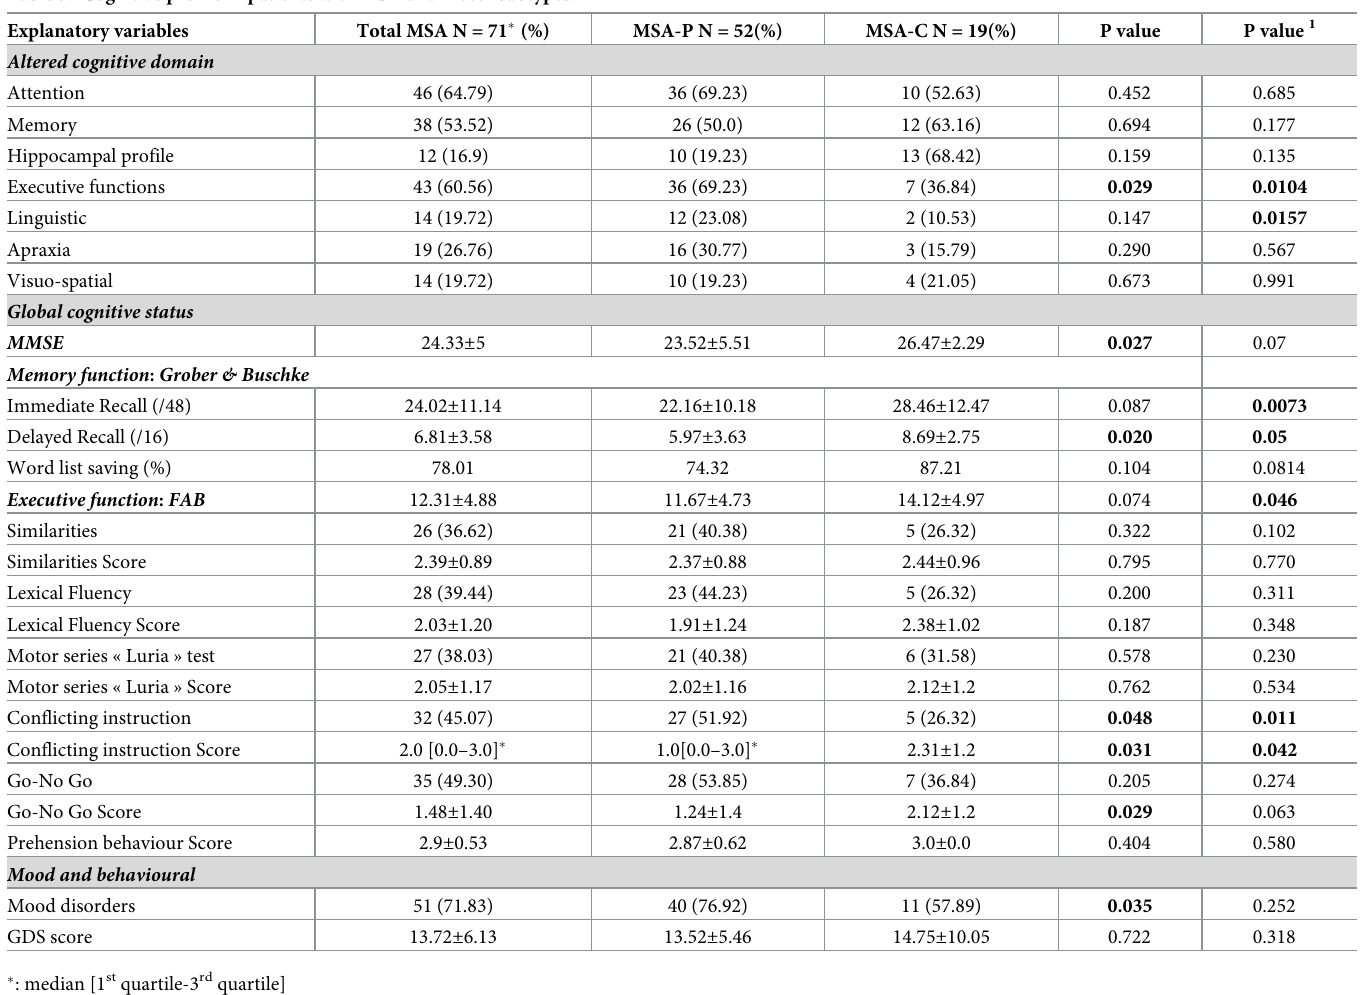
Table 3. Cognitive profile in patients with MSA and motor